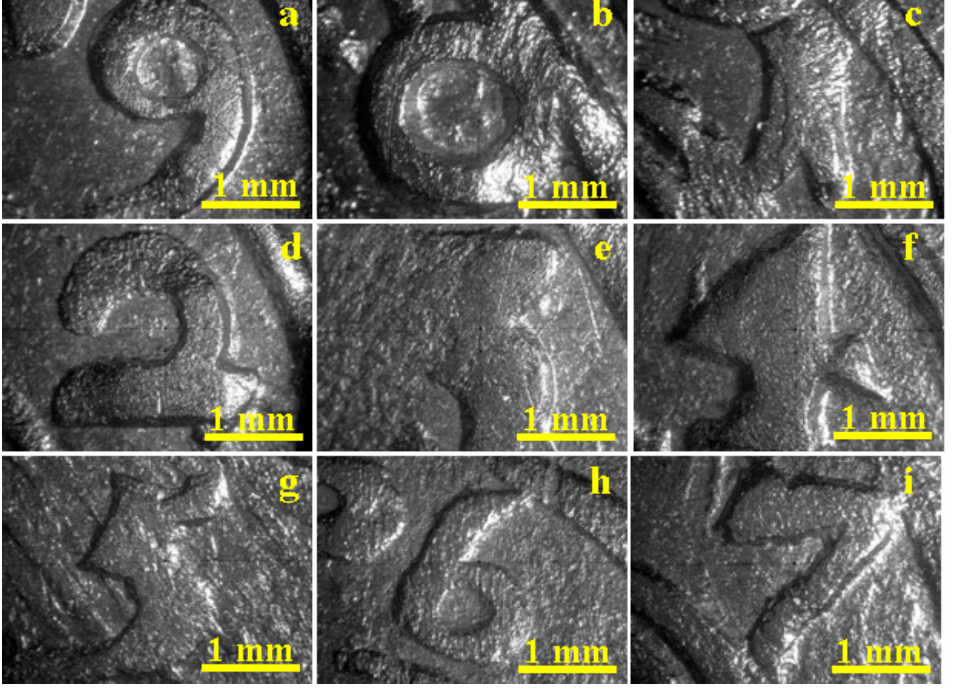
Figure 2. Dark field opticalmicroscopy images of the investigated 3-Polker coins from the minting years: ( a ) 1619, ( b ) 1620, ( c ) 1621, ( d ) 1622, ( e ) 1623, ( f ) 1624, ( g ) 1625, ( h ) 1626, and ( i ) 1627.